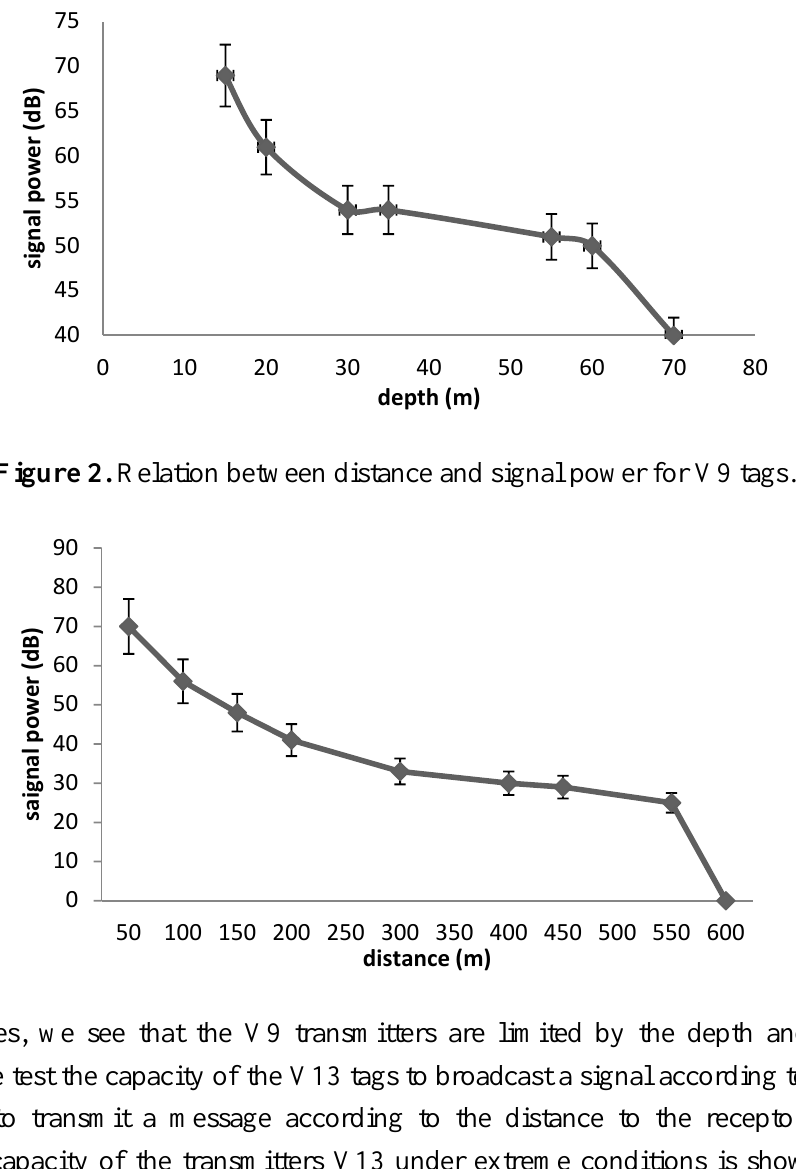
Figure 1. Relation between depth and signal power for V9 tags.